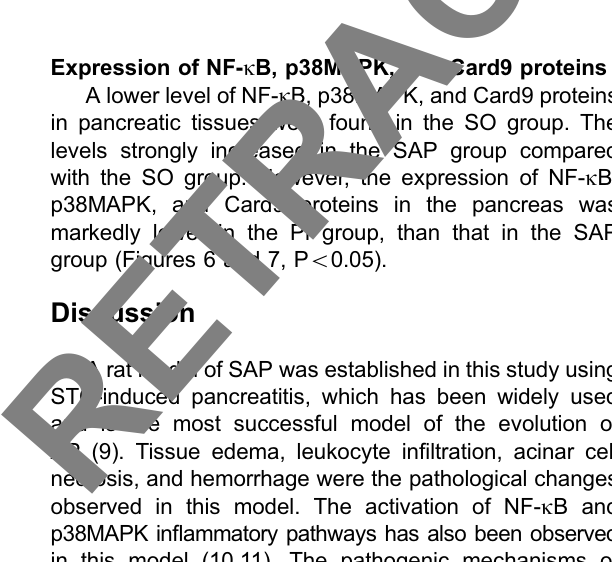
Figure 5. Measurement of Card9, NF-k and p38MAPK mRNA in each group at 3, 6, and 12 h. Data are reported as means ± SD. *P o 0.05 compared with the sham operation (SO) group; # P o 0.05 compared with the severe acute pancreatitis (SAP) group (ANOVA). Pi: pioglitazone